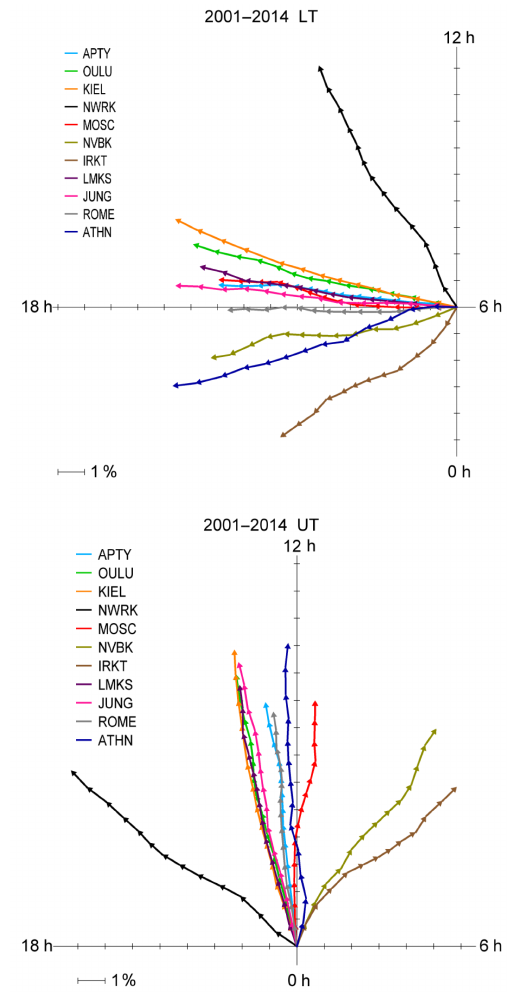
Figure 6. Annual diurnal anisotropy vectors for all NMs for the years 2001–2014 in LT (upper panel) and in UT (lower